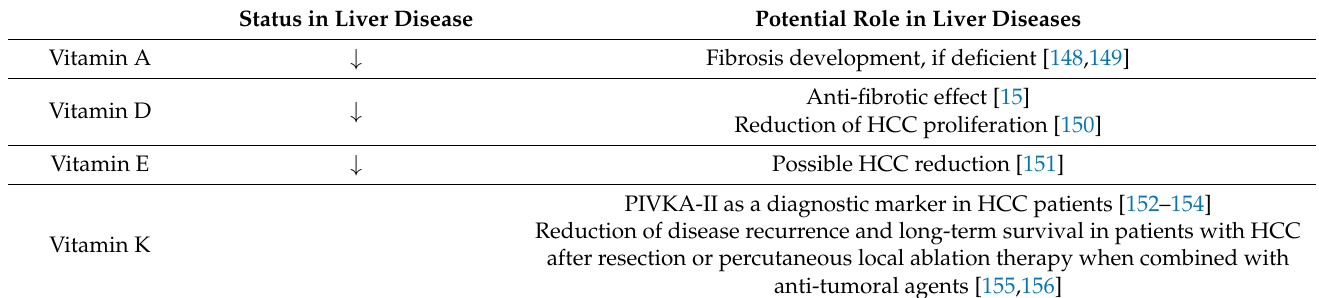
Table 3. Role of vitamin deficiencies in advanced liver disease and